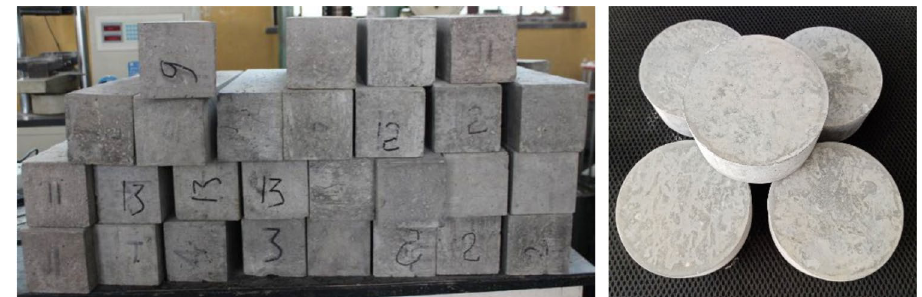
Figure 4. Concrete specimen.